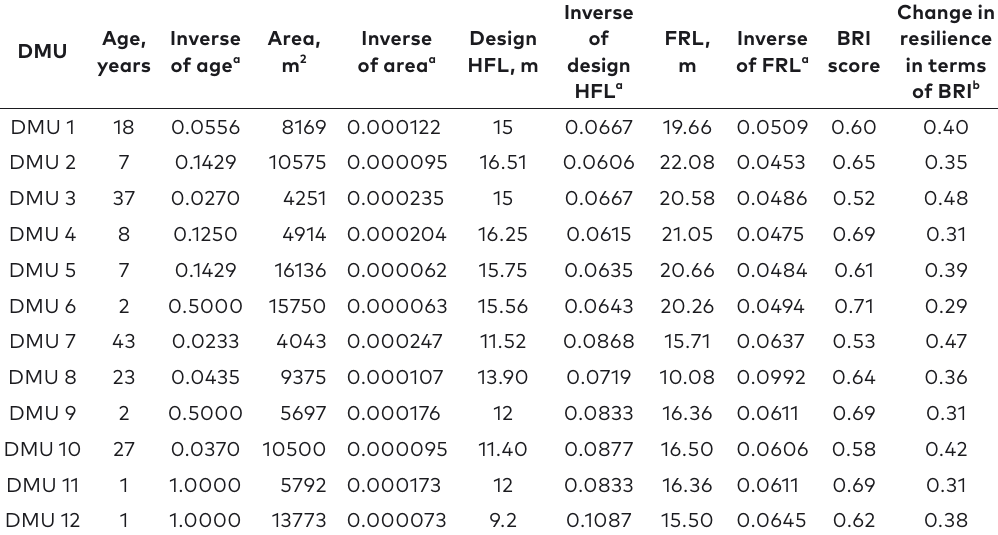
Table 2. Details of input and output